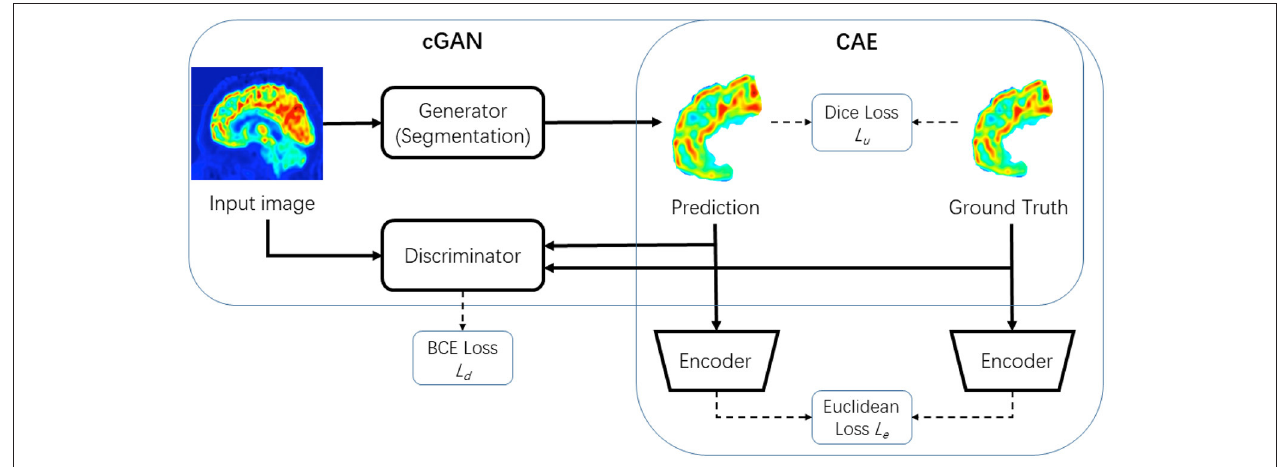
FIGURE 3 | Framework of proposed model FSPET based on conditional generative adversarial network (cGAN) and convolutional auto-encoder